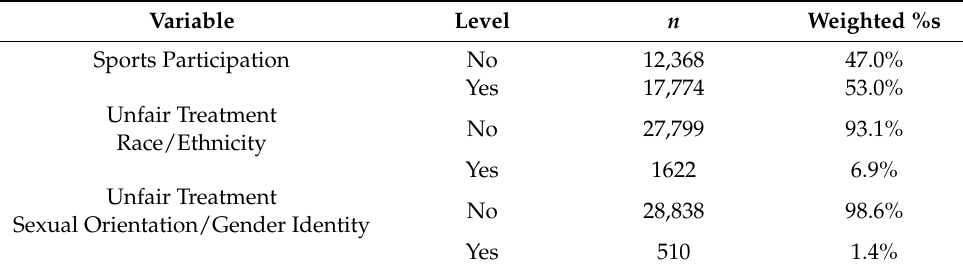
Table 2. Descriptive statistics of the analyzed variables.